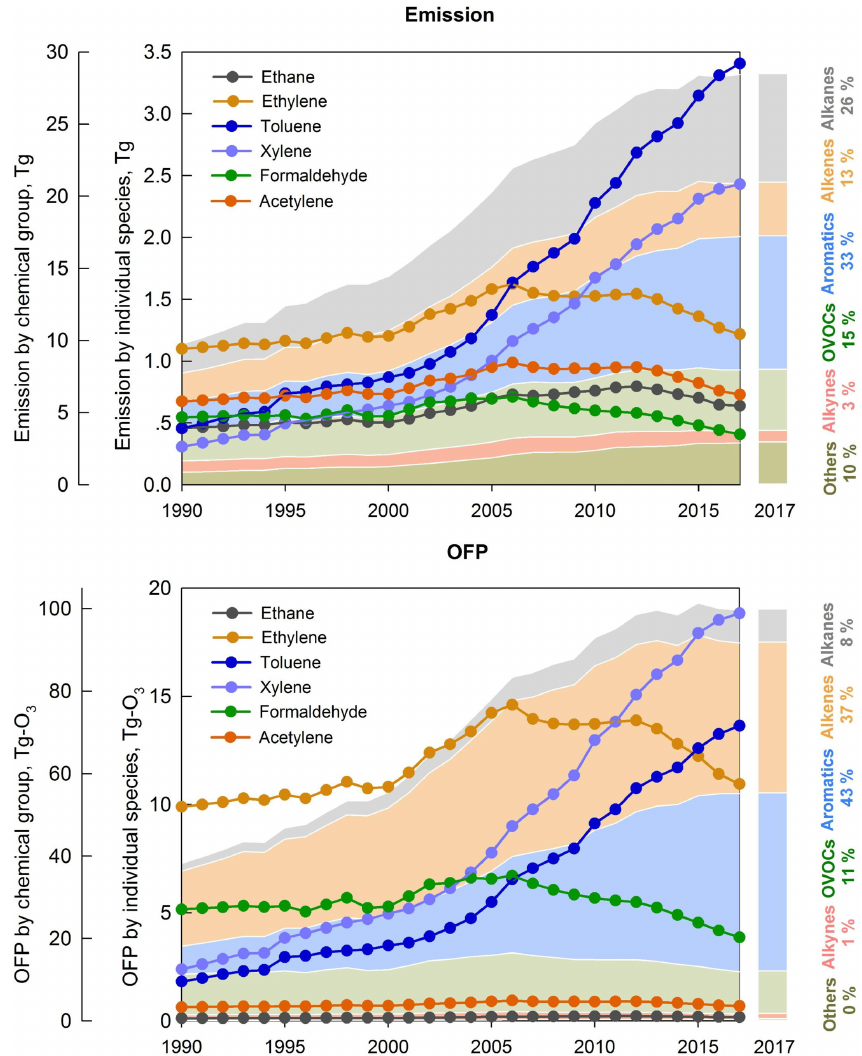
Figure 4. Emission and OFP trends for key chemical species (ethane, ethylene, toluene, xylene, formaldehyde and acetylene) during 1990– 2017. “Xylene” includes all isomers of xylene ( m - and p -xylene and o -xylene).